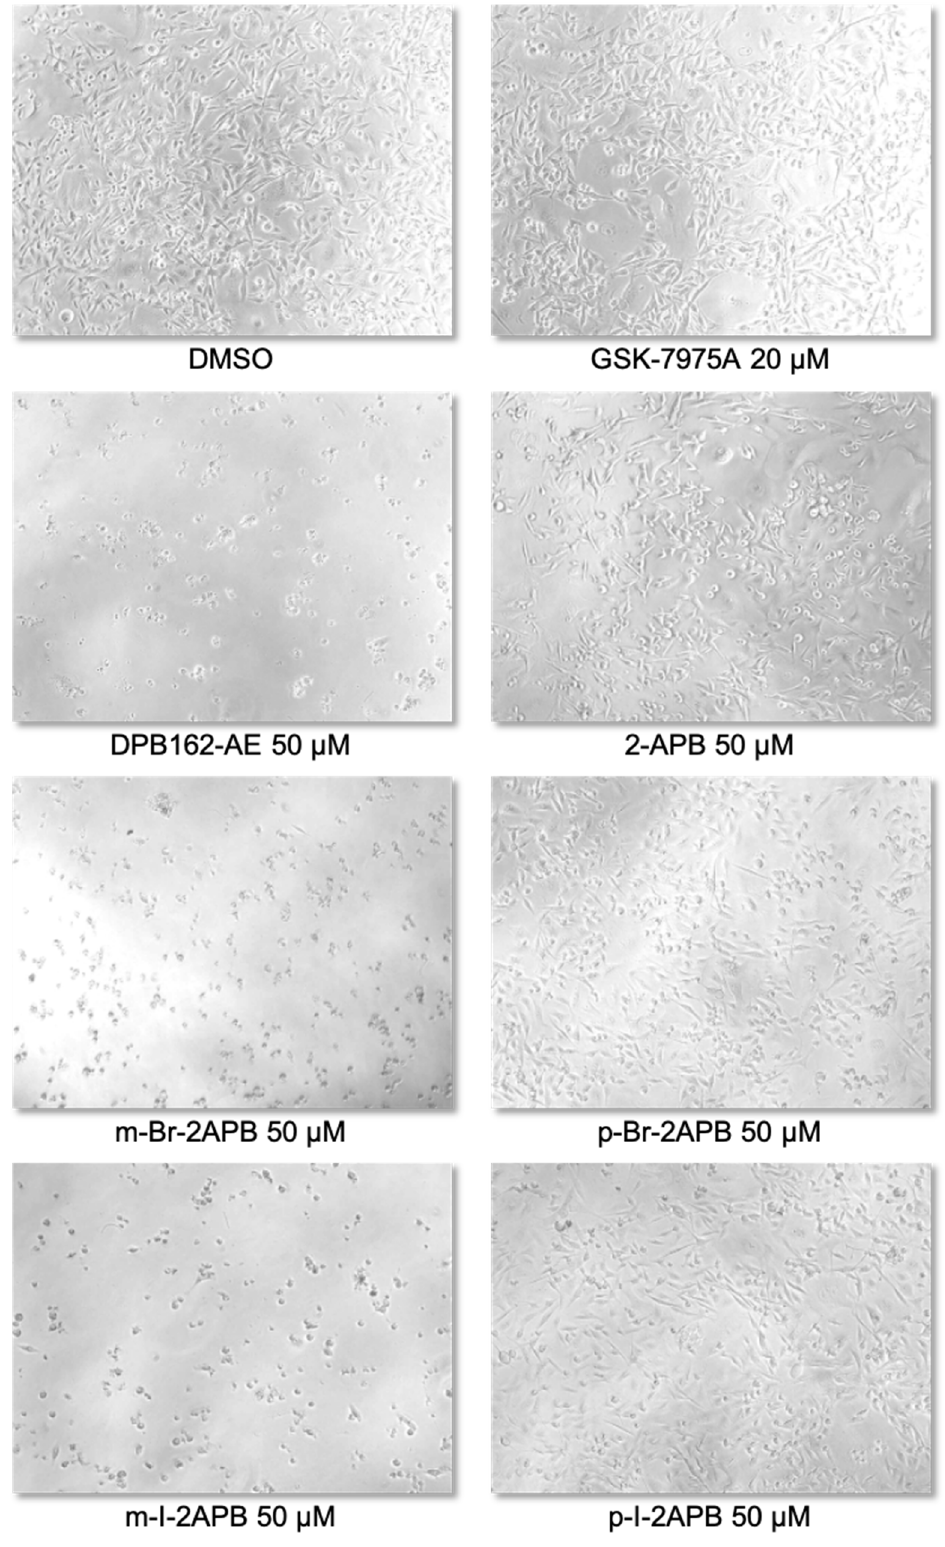
Figure 7. Photomicrographs show the morphological aspects of the cultures of MDA-MB-231 cells after 72 h treatment with control (DMSO) or the indicated compounds. The shown bright-field microscopy images were captured on Nikon Eclipse TiU inverted microscope.